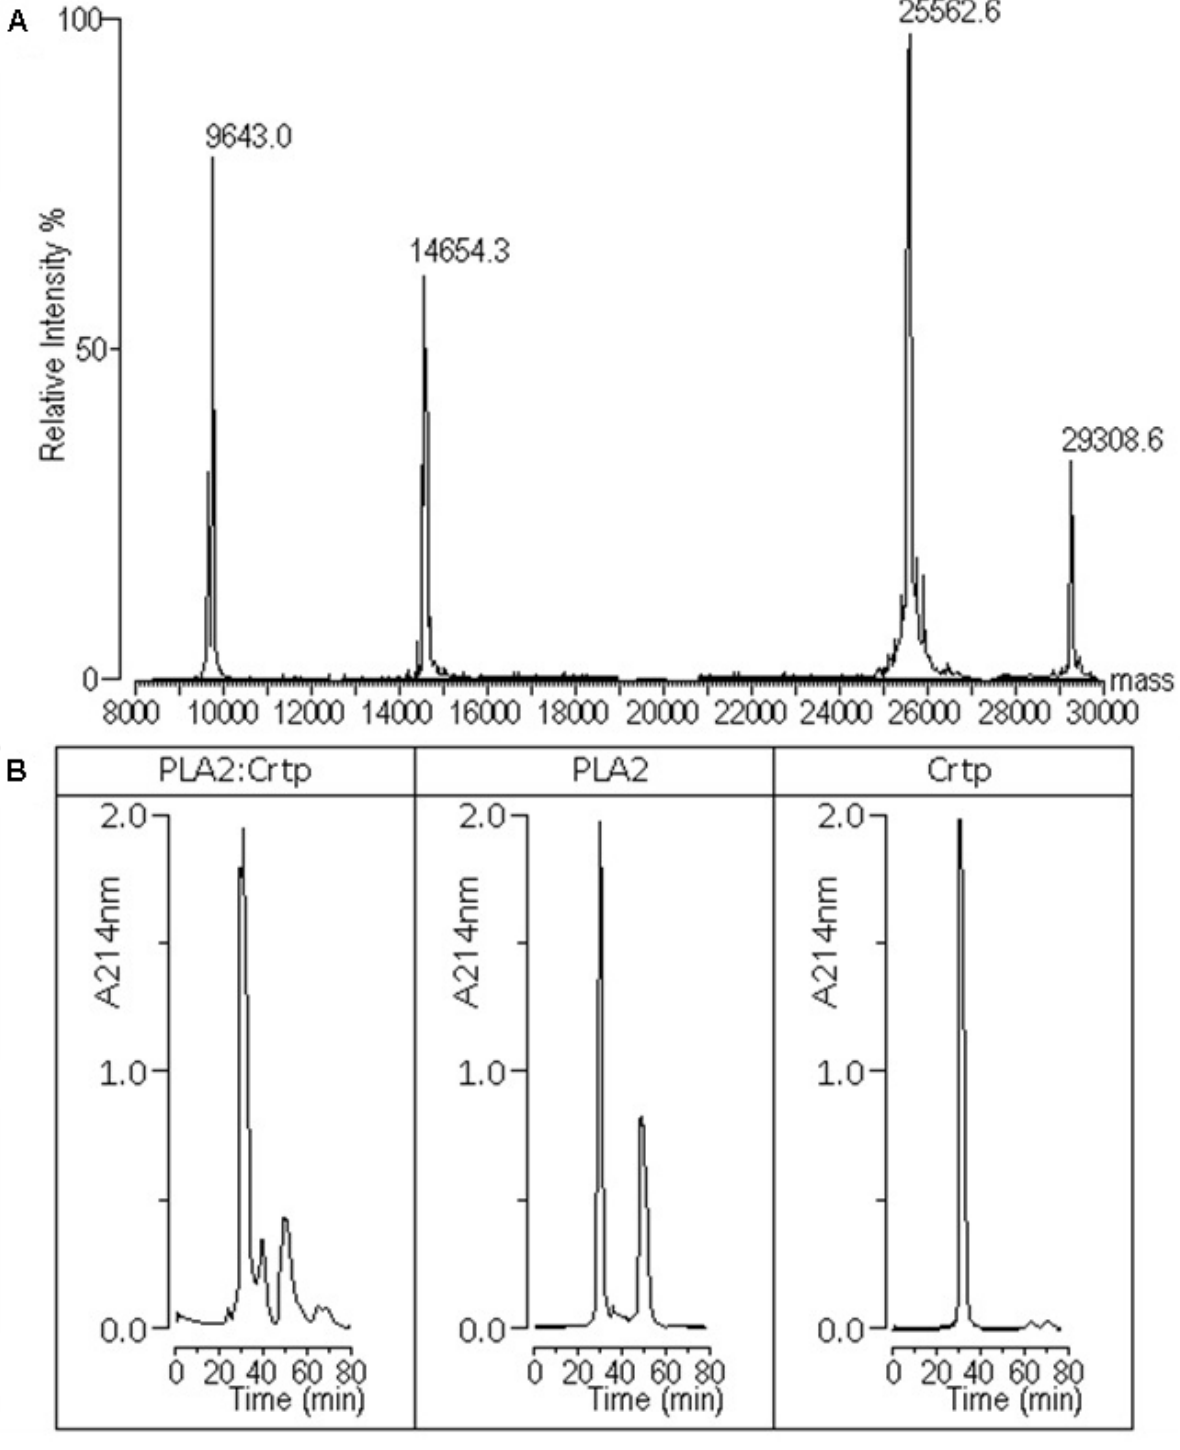
Figure 2. ( A ) The mass spectrometry profile of the crotoxin purified by fractionation of whole venom. In this profile, we observed molecular masses of 9643.0 and 14654.3 Da, which were identified as crotapotin (Crpt) and phospholipase A (sPLA ). Crotoxin is a self-association between sPLA 2 2 the peak of 25562.6 Da in the MS profile. ( B ) The results from the molecular size exclusion chromatography showed that sPLA formed stable homodimers in solution, thus we also identified a possible dimer of sPLA 2 in the MS profile (29308.6